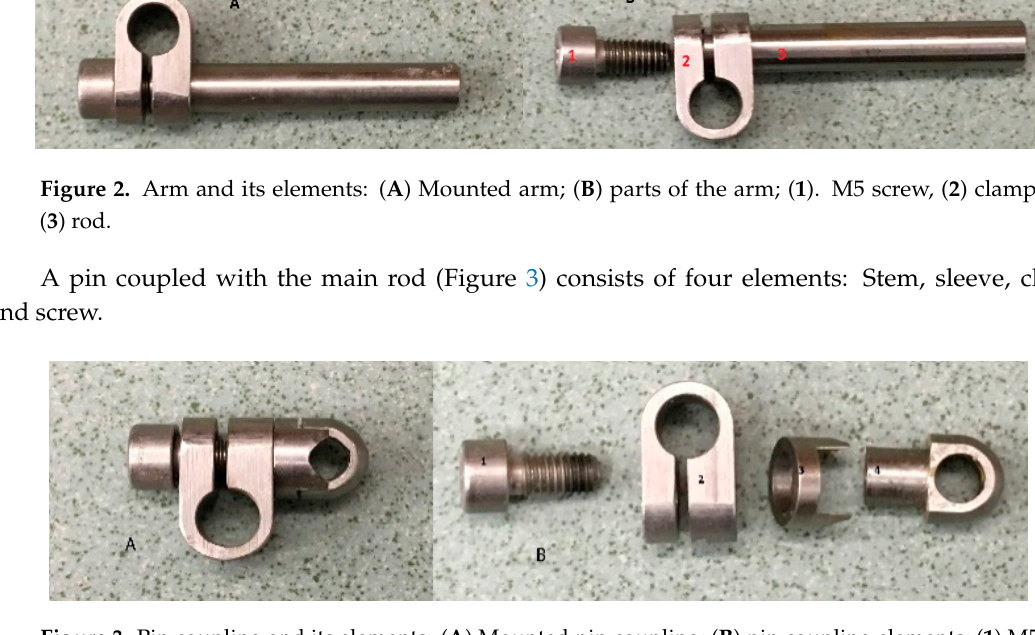
Figure 3. Pin coupling and its elements: ( A ) Mounted pin coupling; ( B ) pin coupling elements; ( 1 ) M5 screw, ( 2 ) clamp, ( 3 ) sleeve, ( 4 ) stem.